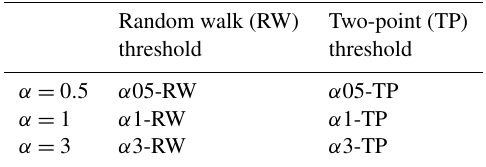
Table 1. Standard deviation algorithm input parameters tested at C1 and S1 in the